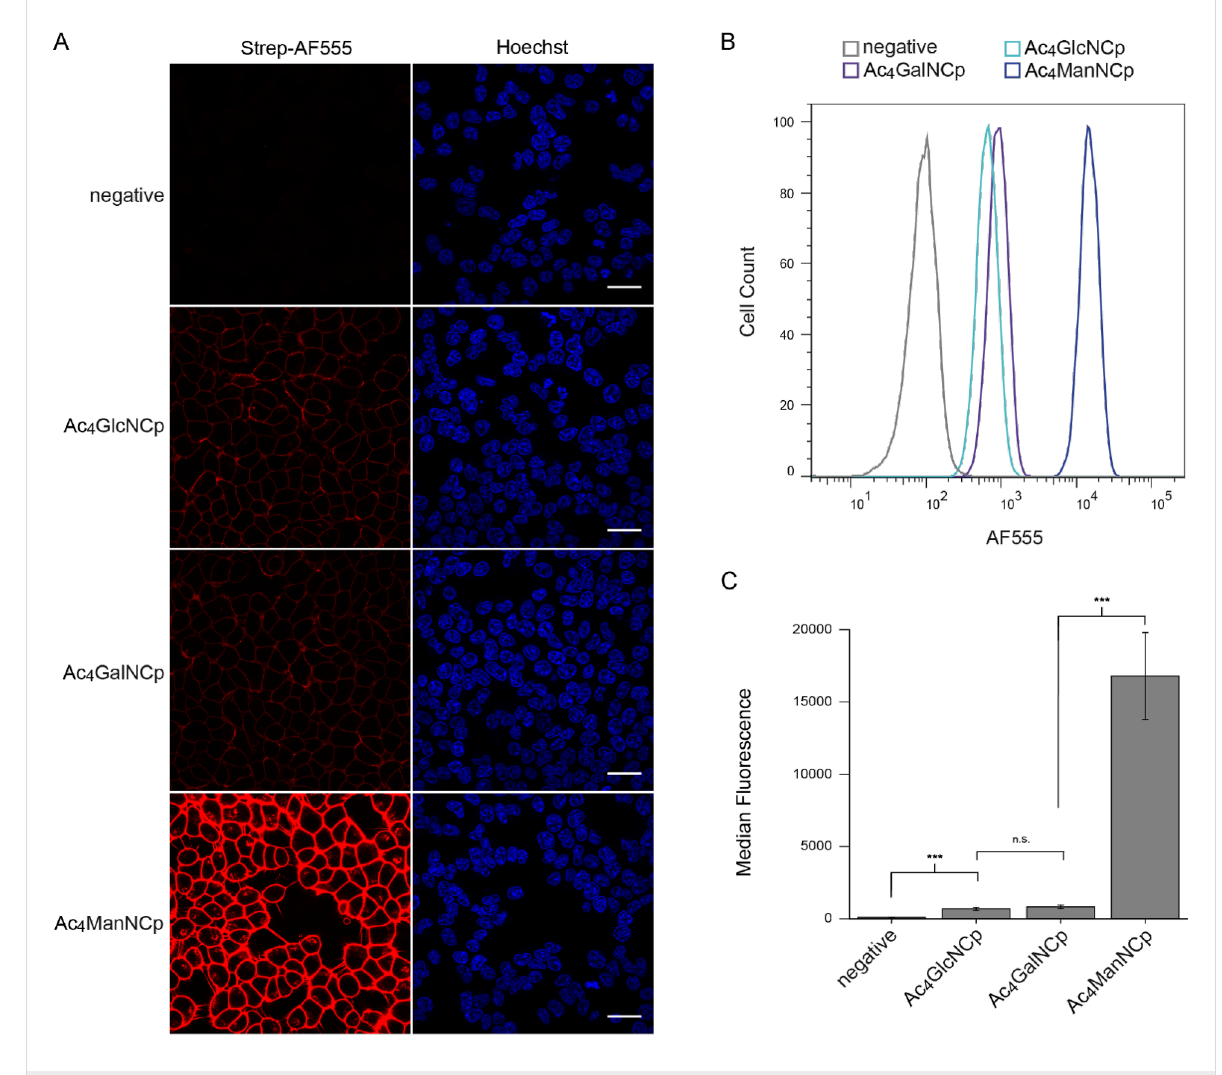
Figure 4: HEK 293T cells were grown with 100 μ M Ac 4 ManNCp, Ac 4 GlcNCp, Ac 4 GalNCp or DMSO only (negative control) for 48 h. Cells were incu- bated with Tz-biotin (A: 500 μ M, B/C: 100 μ M) for 3 h (A) or 30 min (B/C) at 37 °C followed by incubation with strep-AF555. A) Results from confocal fluorescence microscopy. Nuclei were stained with Hoechst 33342. Scale bar: 30 μ m. B) Histogram from flow cytometry experiments. C) Median fluo- rescence from three independent flow cytometry